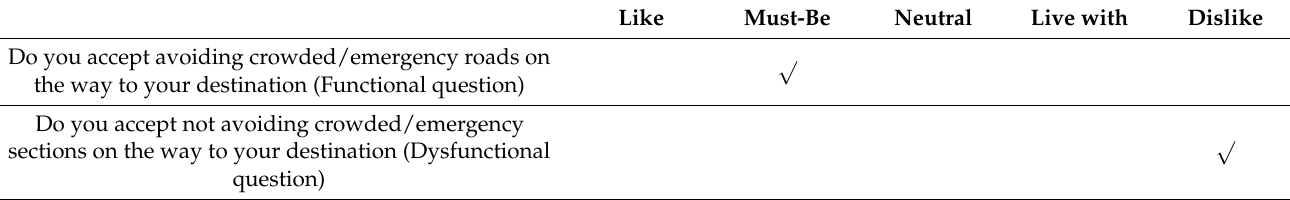
Table 4. Sample functional and dysfunctional questions of Kano questionnaire.